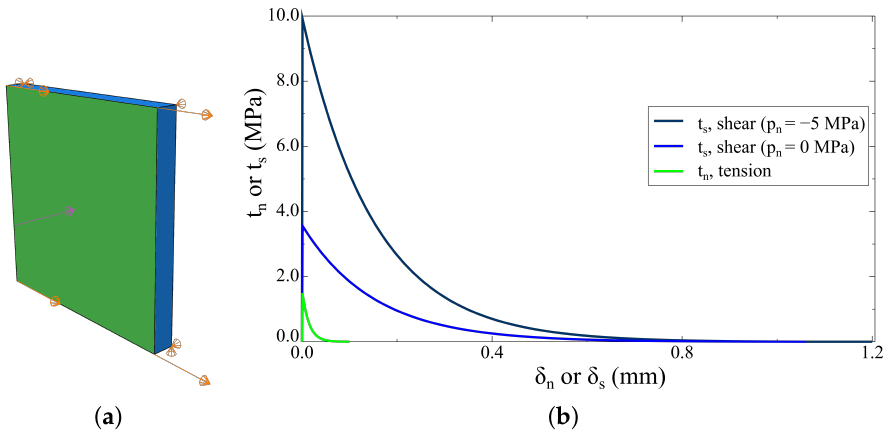
Figure 8. One element tests: ( a ) the numerical model; ( b ) the results for three different loading histories. Table 9. Parameters assumed in the case